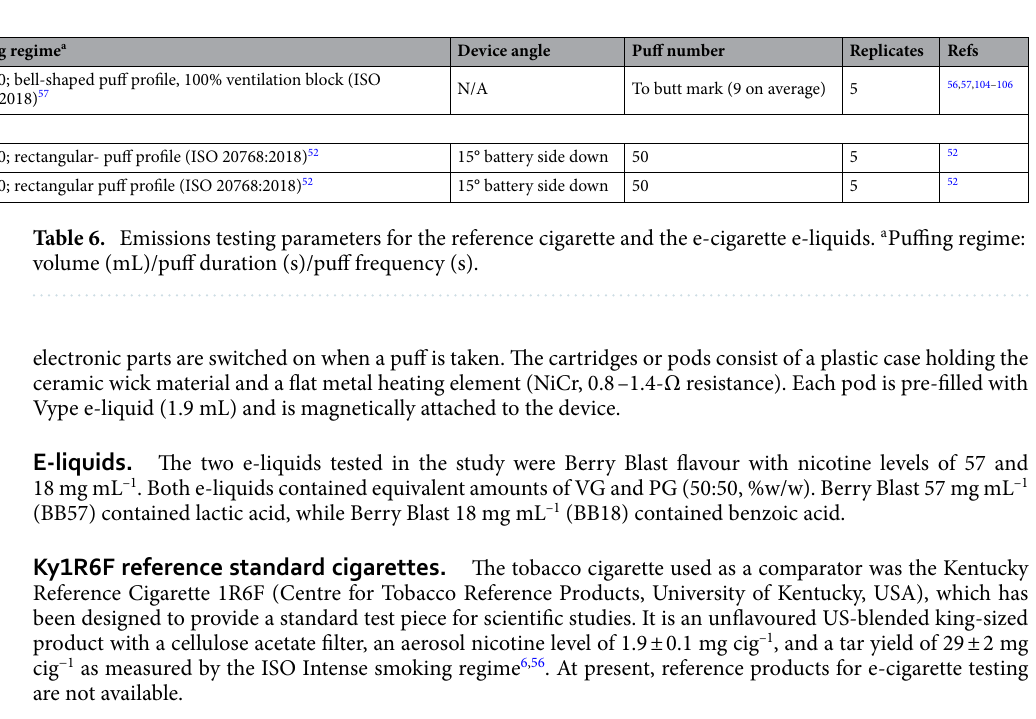
Figure 1. Main components of the Vype e-cigarette device.